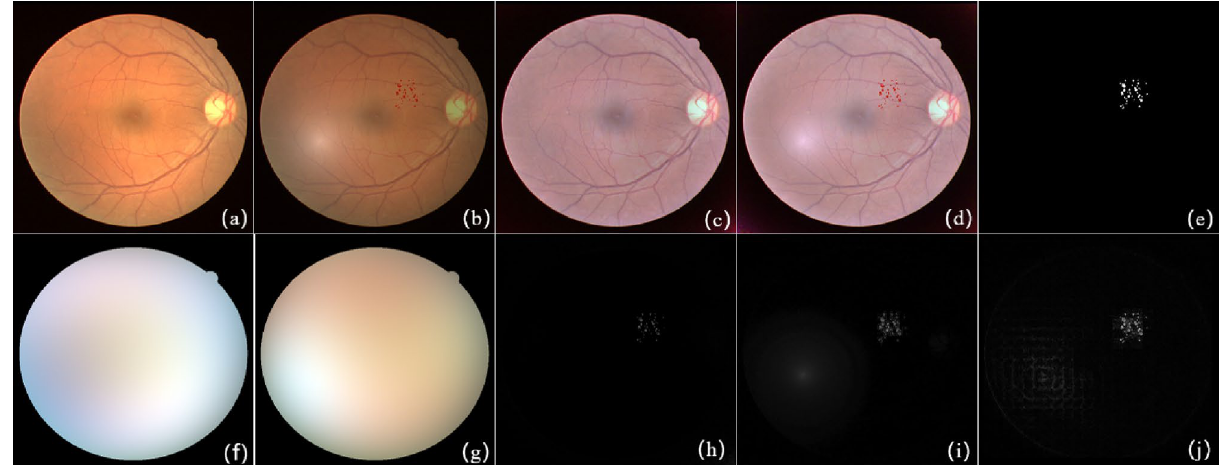
Figure 9. Simulated small lesion image pairs results. ( a ) Reference image; ( b ) current image; ( c ) the corrected reference image with IRHSF; ( d ) the corrected current image with IRHSF; ( e ) the ground-truth; ( f ) the illumination model of the reference image; ( g ) the illumination model of the current image; ( h ) detection result of IRHSF; ( i ) detection result of RPCA; ( j ) detection result of the proposed method in this